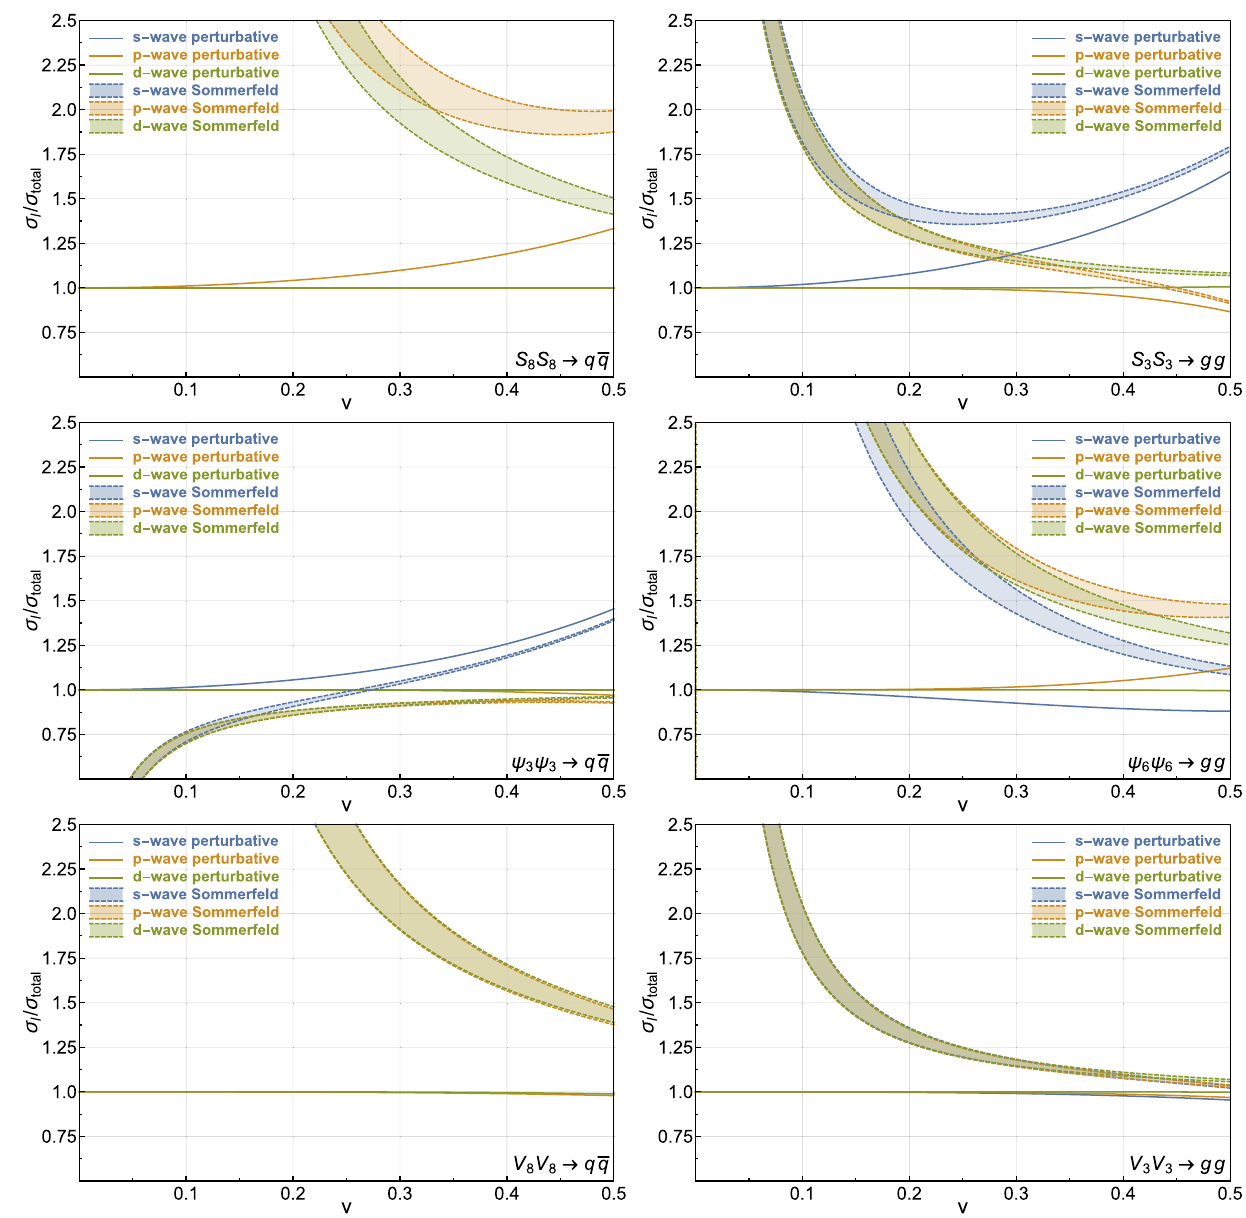
Fig. 3 Ratios of the perturbative ( solid lines ) and Sommerfeld- correctedcrosssections( dashedlines )expandeduptothe s -wave( blue ), p -wave ( orange ) and d -wave ( green ) over the exact value of the per- turbative cross section. Due to the mass dependence of α Sommerfeld s ( ˆ μ) ,